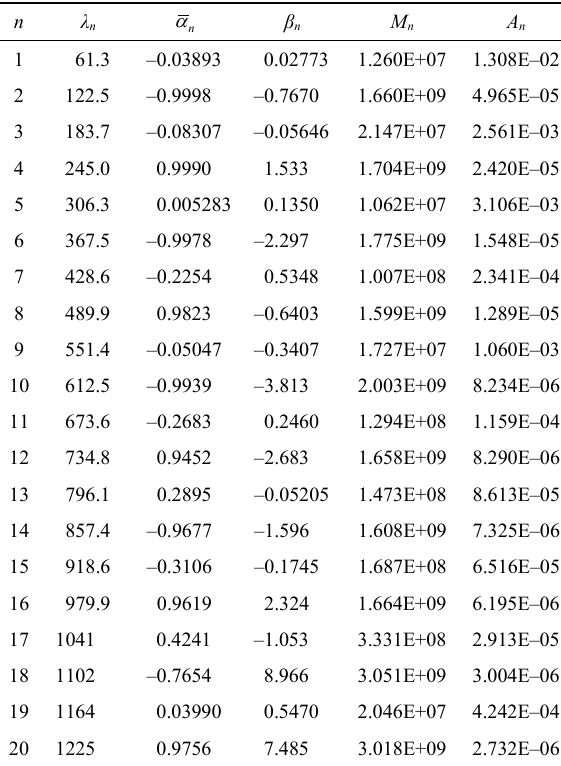
Table A2 Calculation parameters for mullite/Si/RBSC model (non-defect region)